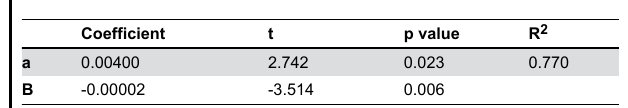
intermediate elevation (Table 3: Figure 2).